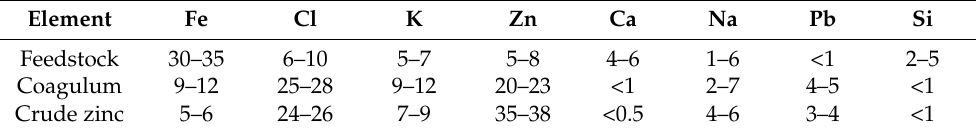
Table 1. Element contents in the feedstock, coagulum, and crude zinc powder (mass %). Element